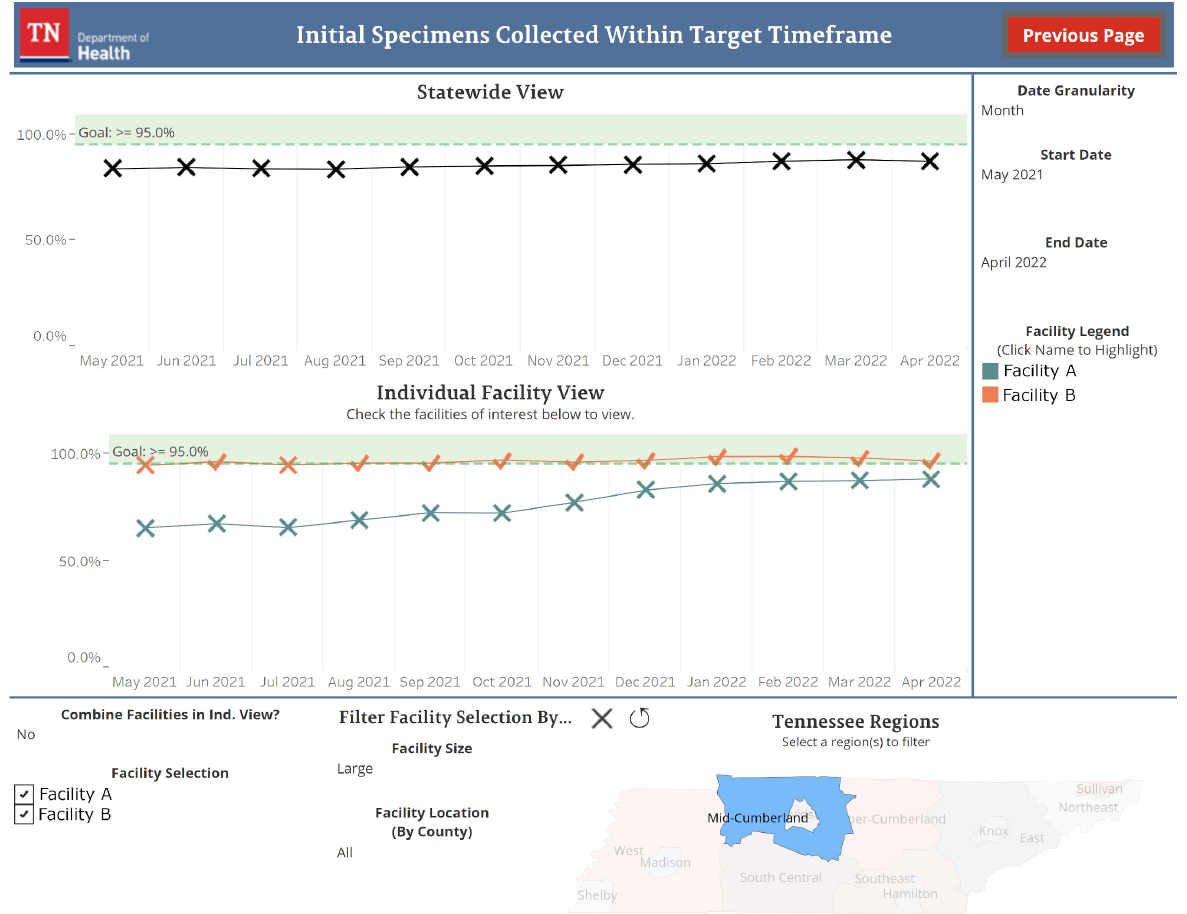
Figure 3. An example of the initial specimens collected within the target time frame indicator view. Individual facilities have been added after filtering for large-sized facilities in the Mid-Cumberland Tennessee region. Facility names in this figure have been anonymized for use in this manuscript. The time period and date granularity have not been adjusted from their default